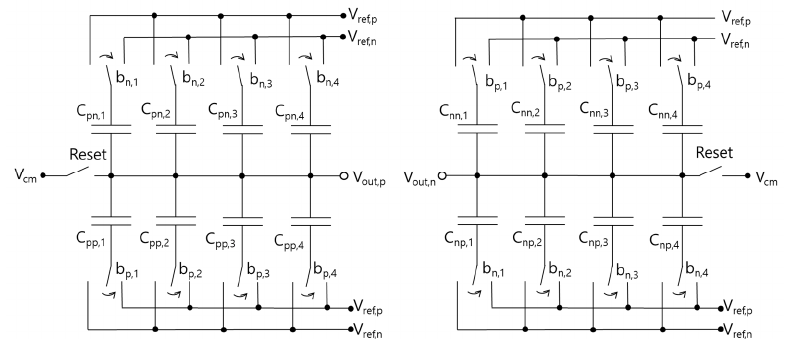
Figure 10. Split-Array C-DAC with differential output.